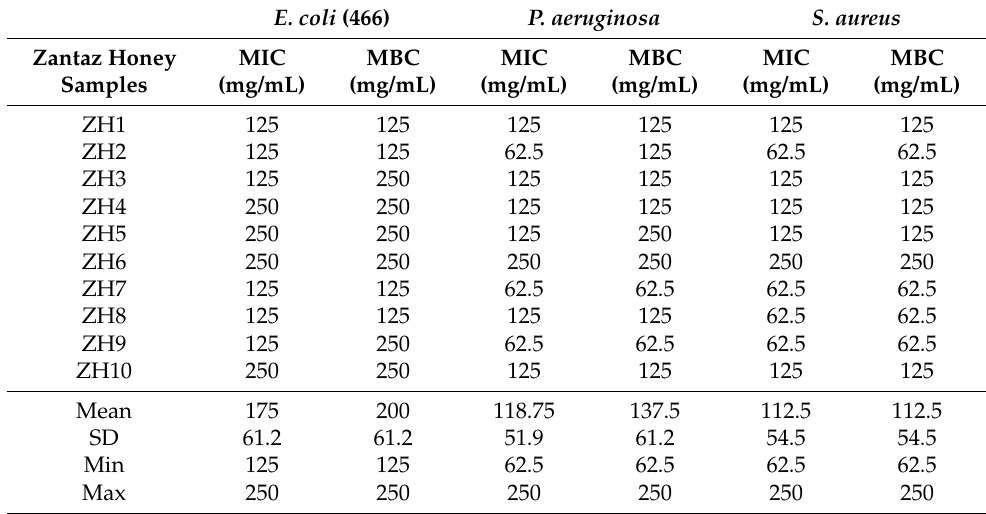
Table 2. Antibacterial activity of Zantaz honey against E. coli , P. aeruginosa and S. aureus . E. coli